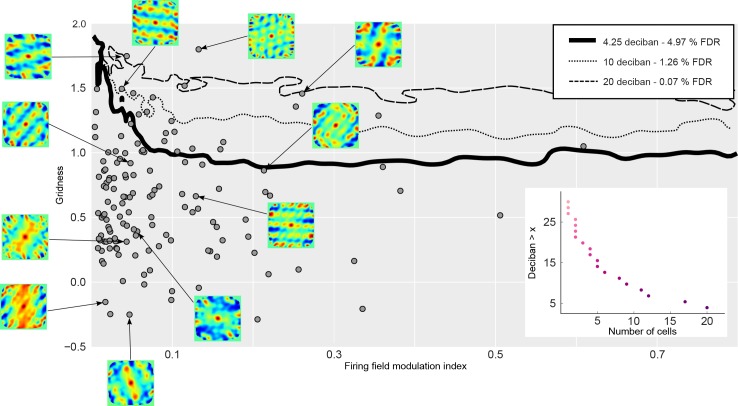
Classification of grid cells.Gray filled circles indicate gridness and firing field modulation index values for our recorded EC units. Solid curves show contours of the log likelihood ratio (in deciban) that indicates evidence in favor or against a cell being a grid cell. 4.25 deciban (thick line) corresponds to a false discovery rate (FDR) of <5% in our simulations, 10 deciban (10:1 odds ratio, thin dotted line) to a FDR of 1.26% and 20 deciban (thin dashed line) to a FDR of 0.07%. The FDR indicates how many simulated non-grid cells are classified as grid cells with each log likelihood ratio value. Cells above the curves are likely grid cells. Small insets with arrows show the 2D autocorrelation for example cells. Inset panel shows how many cells exceed a specific deciban threshold.